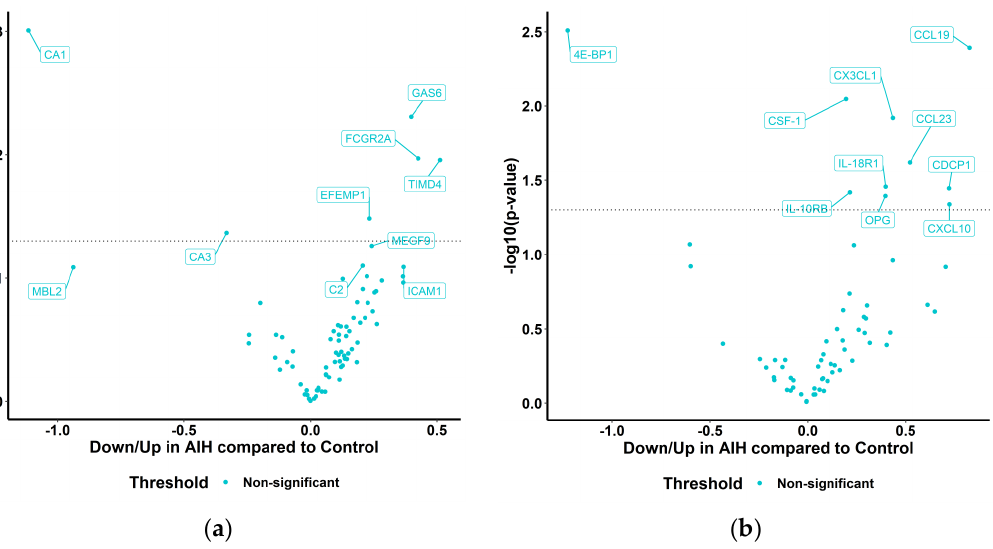
Figure 4. Volcano plots representing differentially abundant proteins (DAP) in AIH compared to controls in the Cardiometabolic and Inflammation panels. Welch 2−sample t−test or paired t−test at a confidence level of 0.95 for every protein; p value shown as logarithm in base 10 on the y-axis. ( a ) Cardiometabolic and ( b ) Inflammation panels.